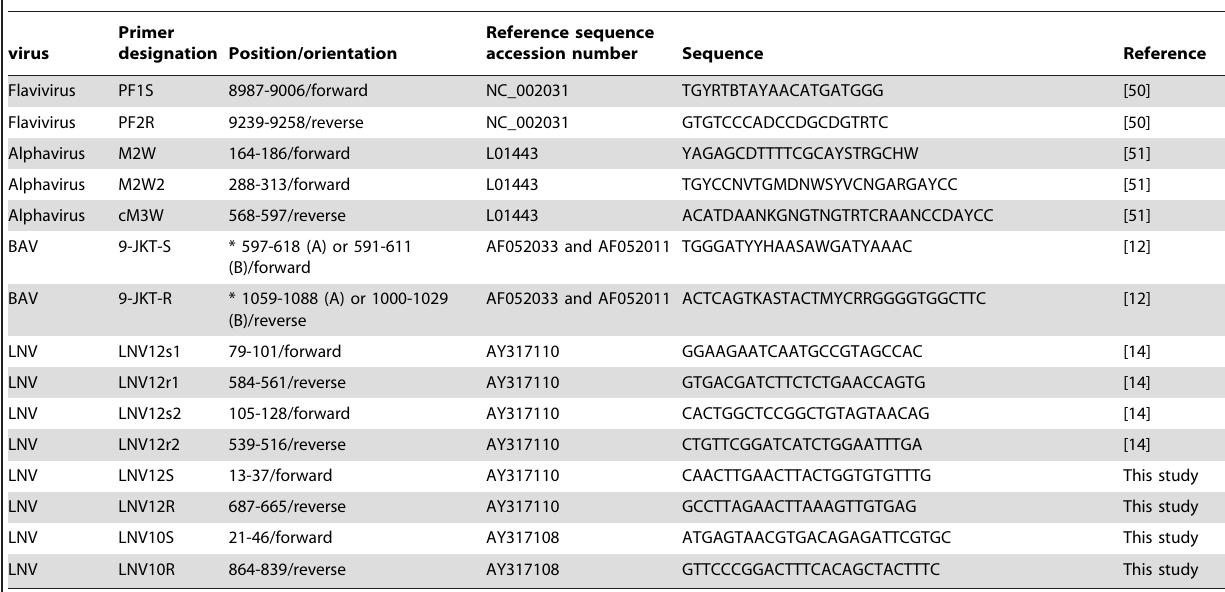
Table 2. List of primers used in PCR